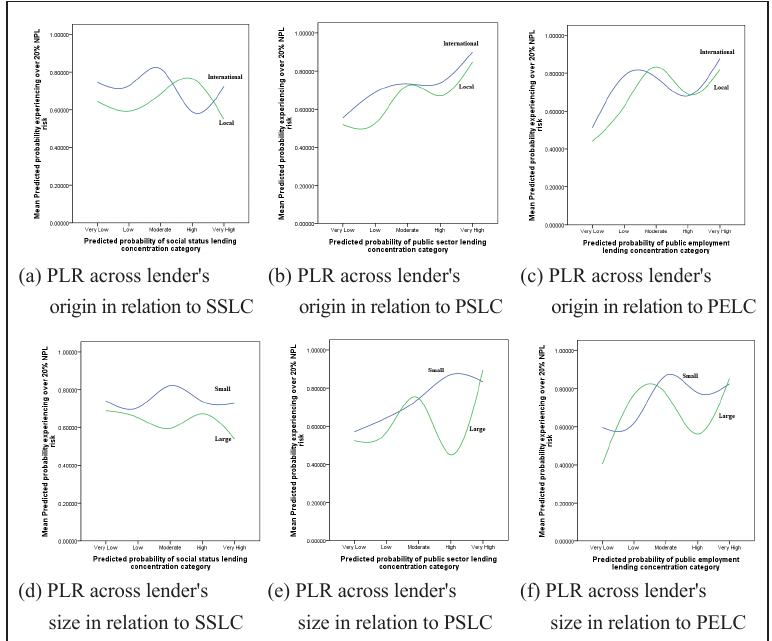
Figure 5 NPL Risk in Relation to Lending Concentration in Relation to Originality and Size of